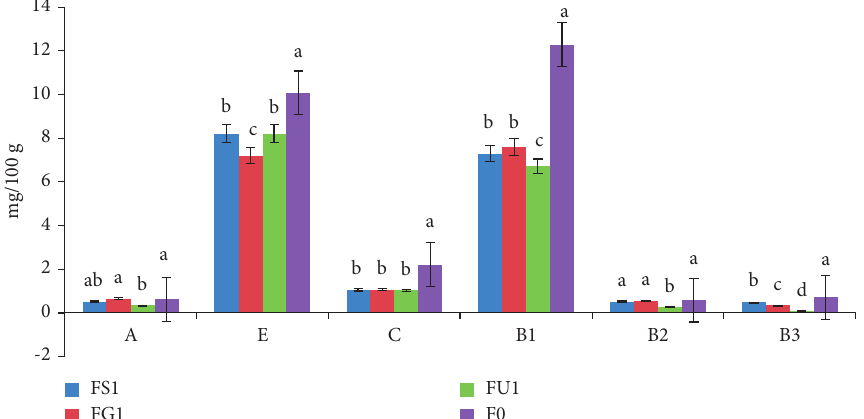
Figure 2: Vitamin content of sour fruits with 1.5% algae powder. Different letters indicate significant differences ( p < 0 . 05 ) .